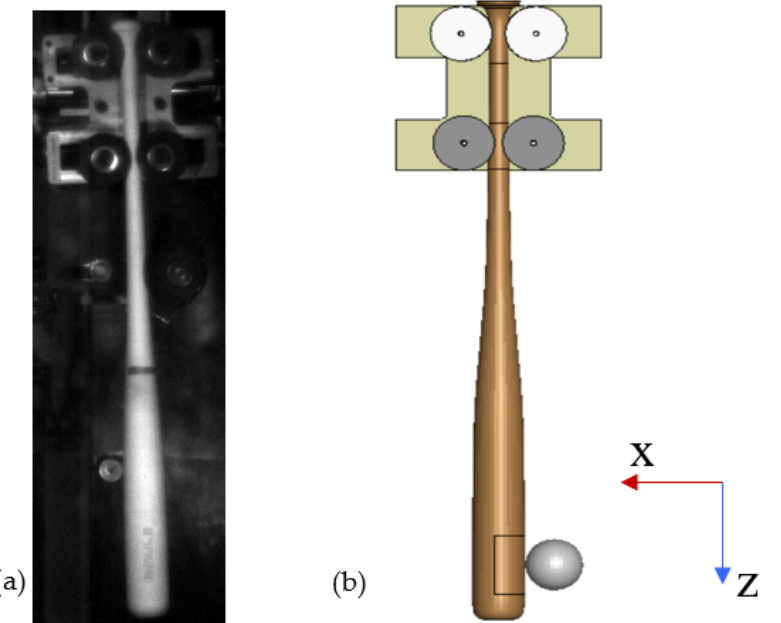
Figure 3. Comparison of ( a ) bat in ADC Bat Durability System and ( b ) finite element model of the bat in the ADC system. Note: rectangular box on the bat surface indicates the contact area for impact.